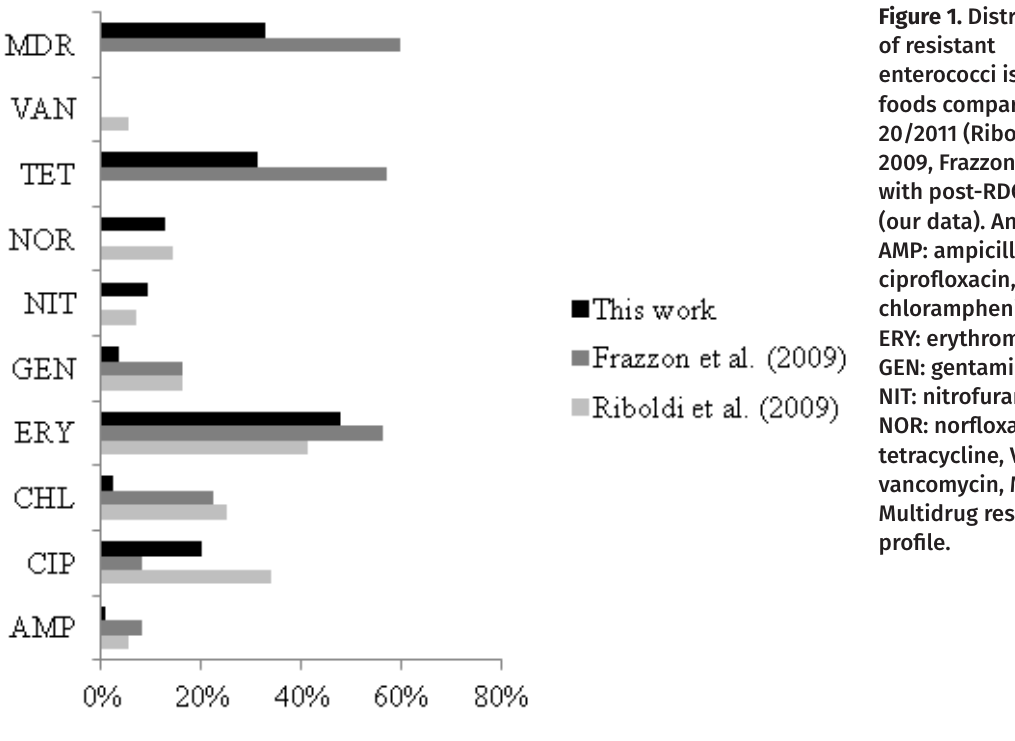
Figure 1. Distribution of resistant enterococci isolated from foods comparing